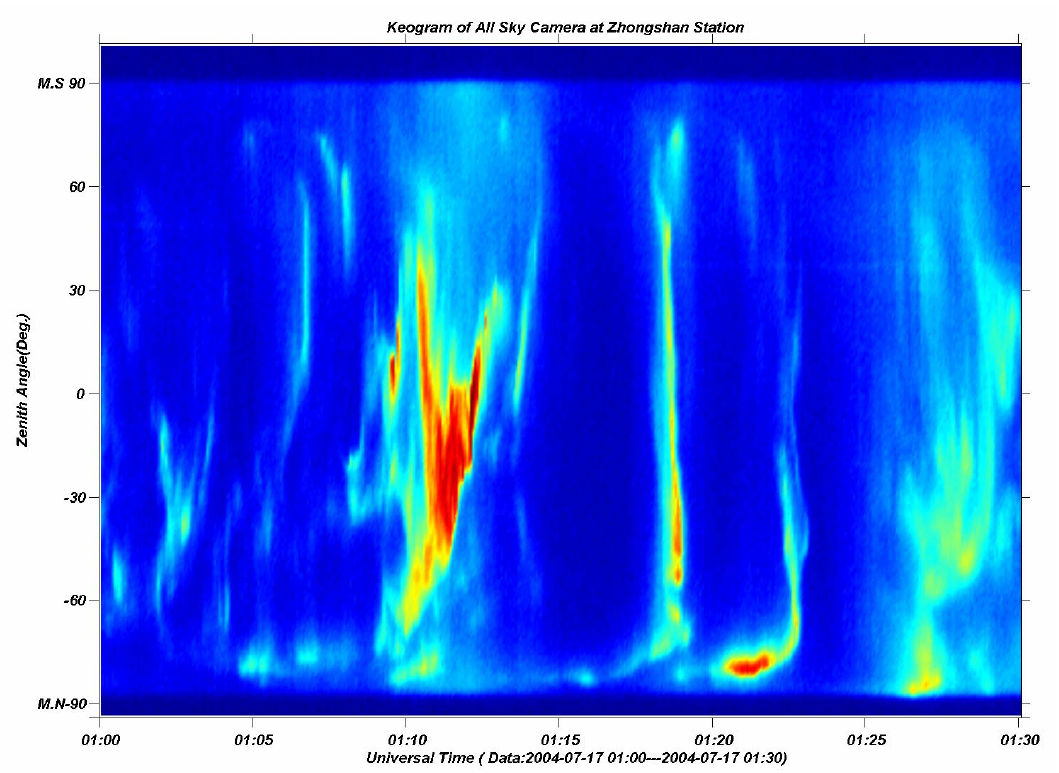
Fig. 3. The Keogram derived from the all-sky TV camera at Zhongshan Station during 01:00–01:30 UT on 17 July Fig. 3 The Keogram derived from the all sky TV camera at Zhongshan Station during 01:00-01:30 UT on 17 July 2004.